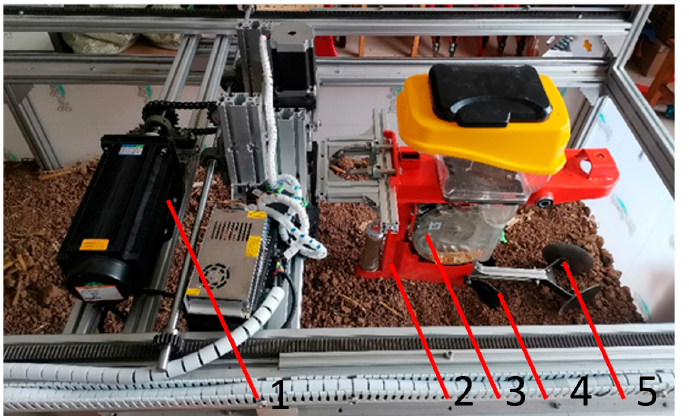
Figure 14. Equipment for soil tank test: 1—motor; 2—opener; 3—seed metering device; 4—dividing plate; 5—covering disc.